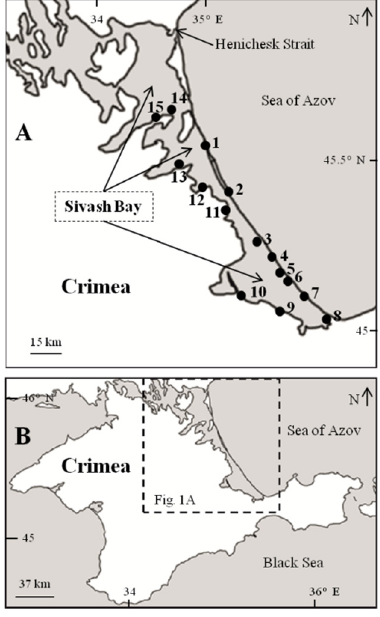
Figure 1. Bay Sivash with sampling stations (( A )—Bay Sivash in Crimea; ( B )—Crimea in the Black Sea).